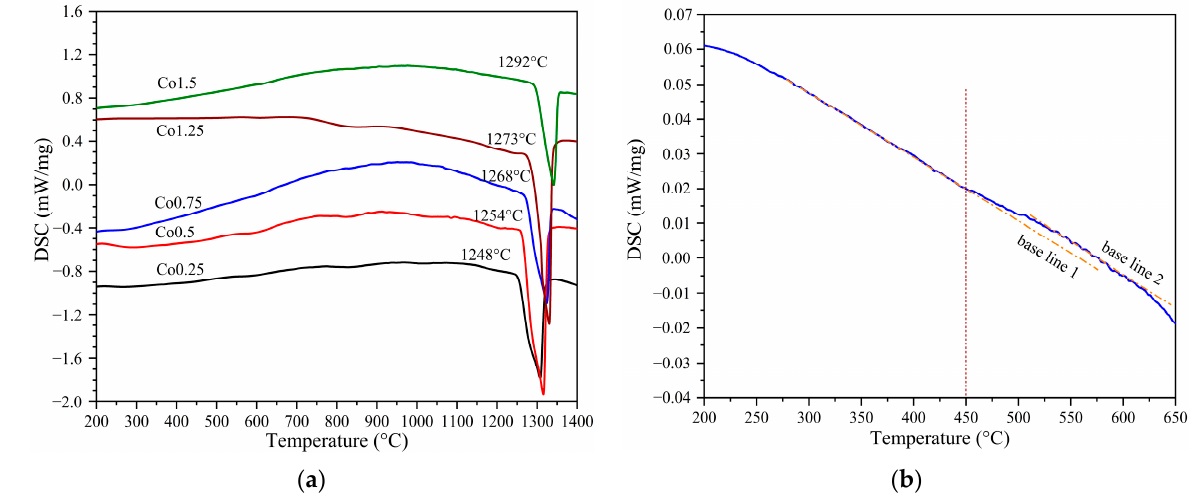
Figure 3. The DSC heating curves of the as-cast Co x CrFeMnNi 2 − x alloy. ( a ) Co 5 Ni 35 -Co 30 Ni 10 ; 20 K/min; ( b ) Co 35 Ni 5 , 5 K/min.